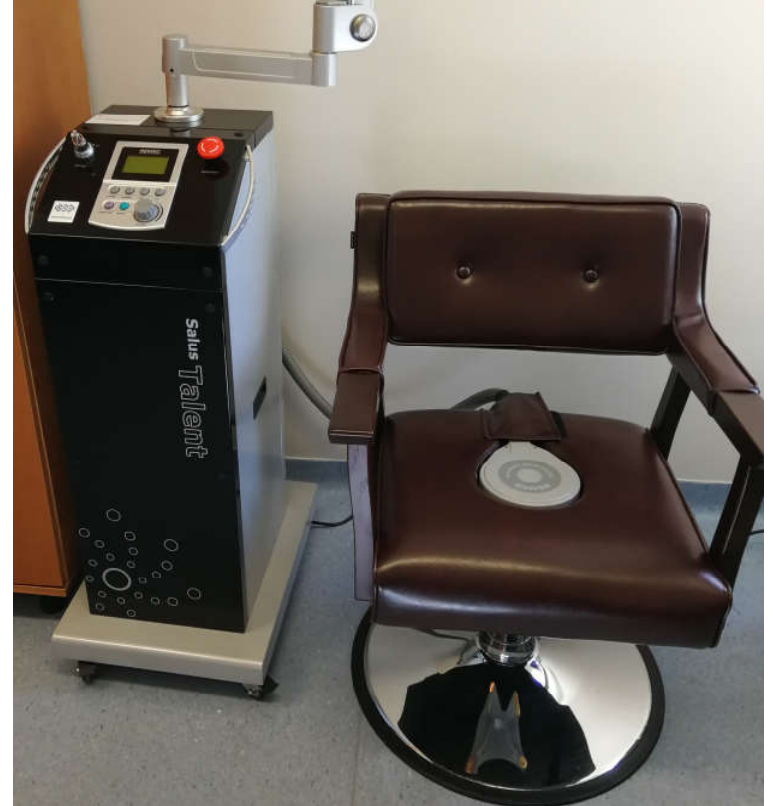
Figure 1. The device used for carrying out the intervention with high-inductive electromagnetic stimulation (HIES).